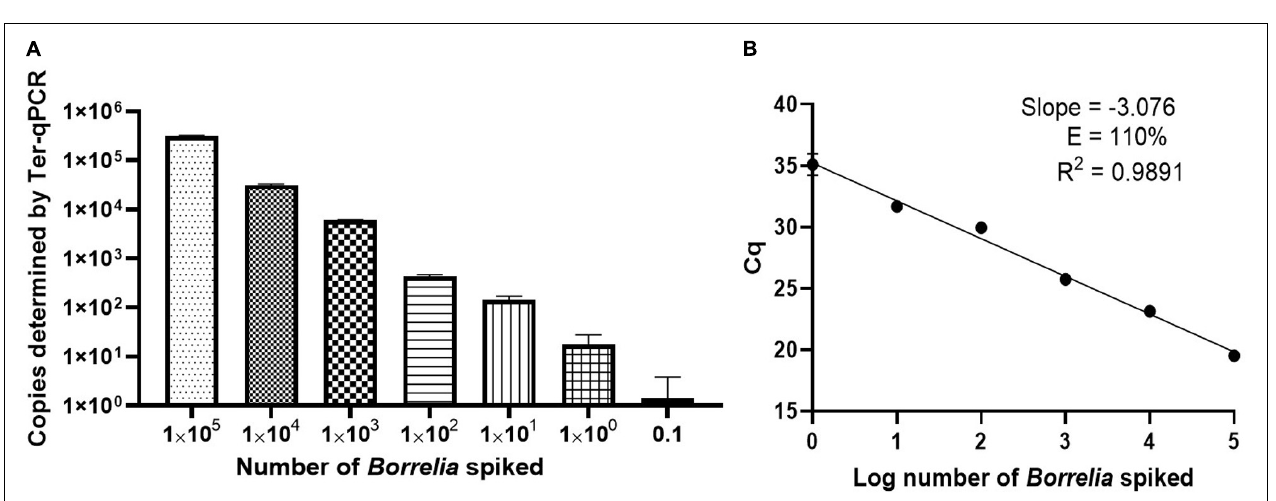
FIGURE 3 | The Ter-qPCR against serial dilutions of the Ter-plasmid and B. burgdorferi B31 DNA to measure the LoD and PCR efficiency: (A) Ter-plasmid and (B) B31 DNA. Cq values were plotted against the log values of serial dilutions of the Ter-plasmid and B31 DNA, respectively. Simple regression analysis was carried out using the Graphpad Prism 8.4.3 software. The slope, coefficient of correlation ( R 2 ) and efficiency of the reaction ( E ) are shown. Each dot represents the average value from triplicate amplifications, along with the SD.